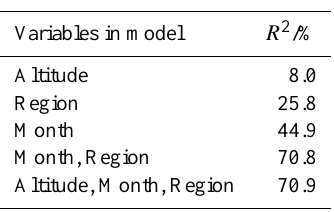
Fig. 3. Temporal parameter estimates for the three regions: cen- tral region (red), southern region (blue) and north-eastern region (green). Table 1. The percentage of explained variance ( R 2 ) for regres- sion models of the mean rainfall. (Based on 4275 site-months of